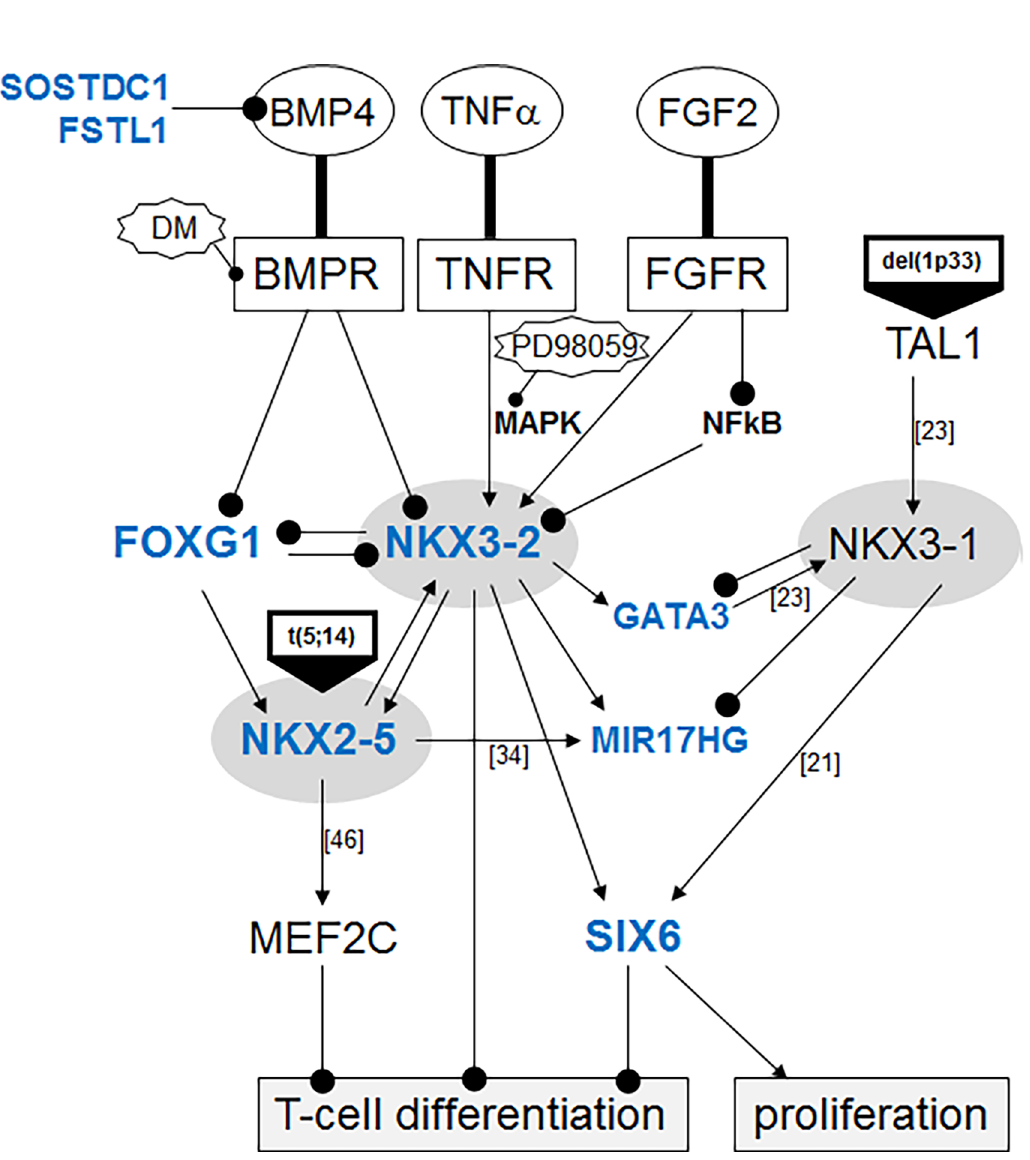
Fig 8. Aberrant gene regulatory network with NKX3-2. This diagram summarizes the results of this study (genes in bold letters) and of previous publications (indicated by the number of the according citation). Collectively, this aberrant gene network essentially contributes to blocked T-cell differentiation because all implicated genes encode basic developmental